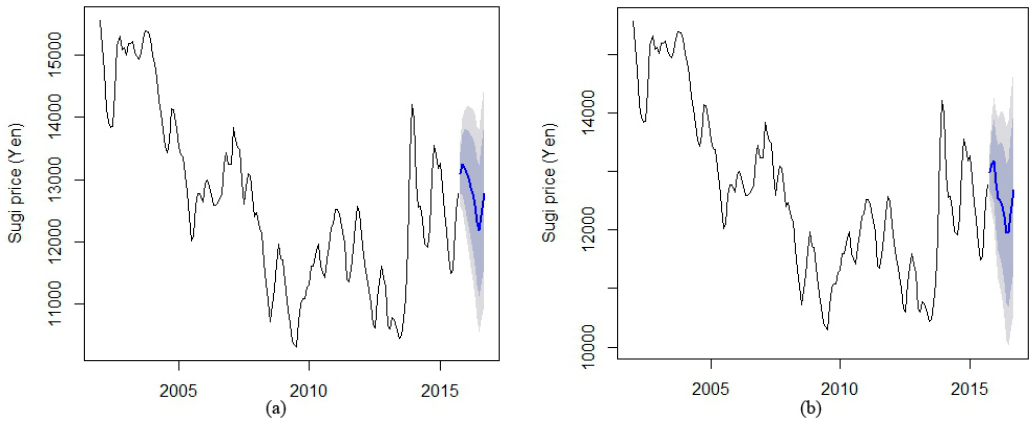
Figure 5. Forecasts of the sugi log prices: ( a ) Point forecasts and forecast intervals at 80% and 95% levels by exponential smoothing method (ETS); ( b ) point forecasts and forecast intervals at 80% and 95% levels by autoregressive integrated moving average (ARIMA).